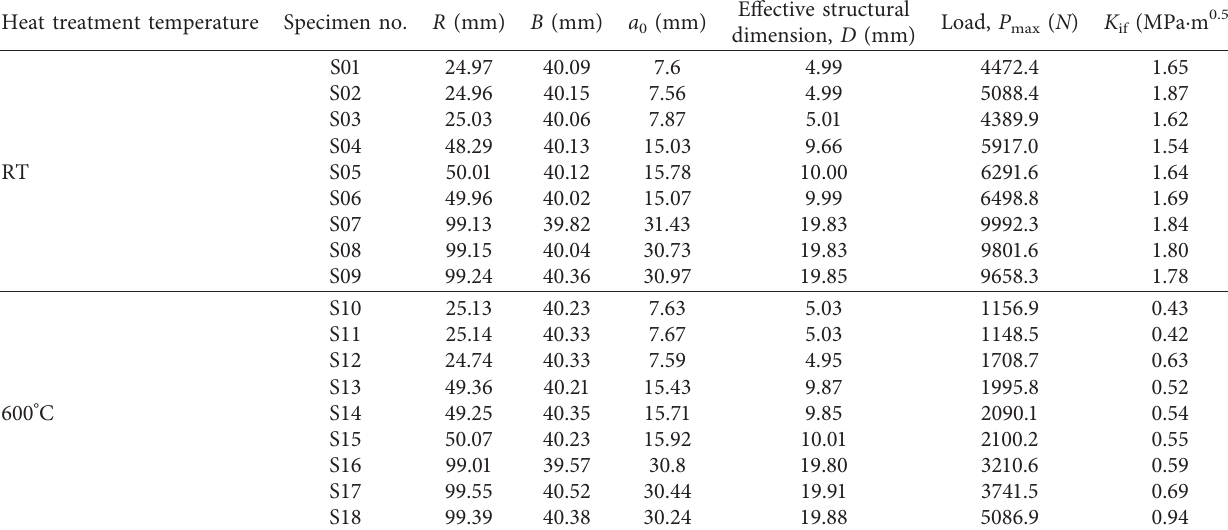
Figure 6: X-ray diffraction results of granite samples. Table 3: The apparent fracture